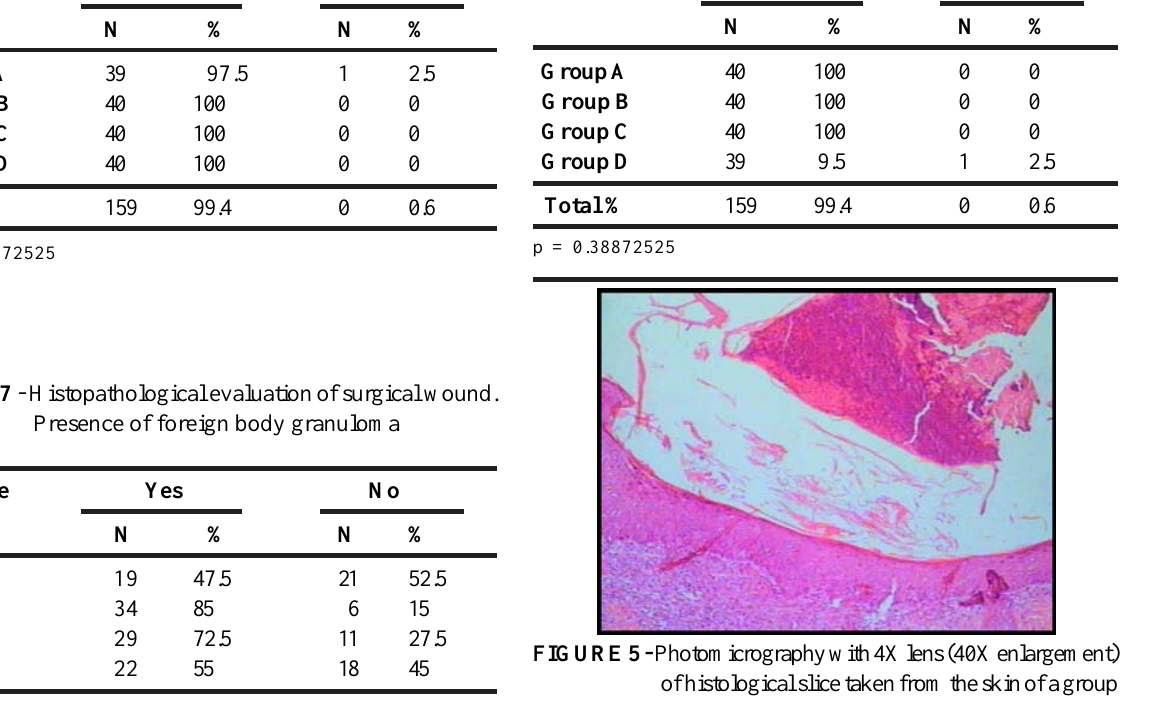
FIGURE 5 - Photomicrography with 4X lens (40X enlargement) of histological slice taken from the skin of a group C rat, stained with HE, Showing crust on the surface and complete